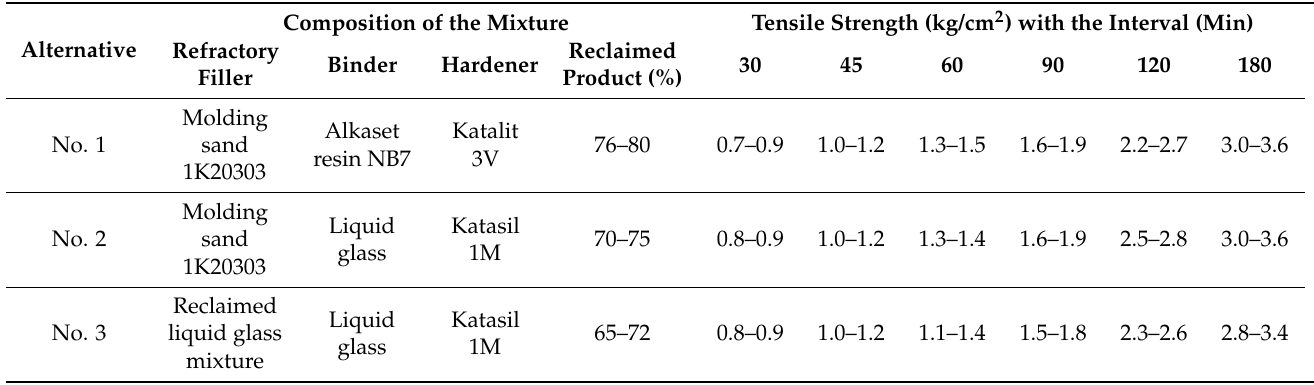
Table 1. Mechanical properties of molding mixtures made with different recipes with the product reclaimed from the line